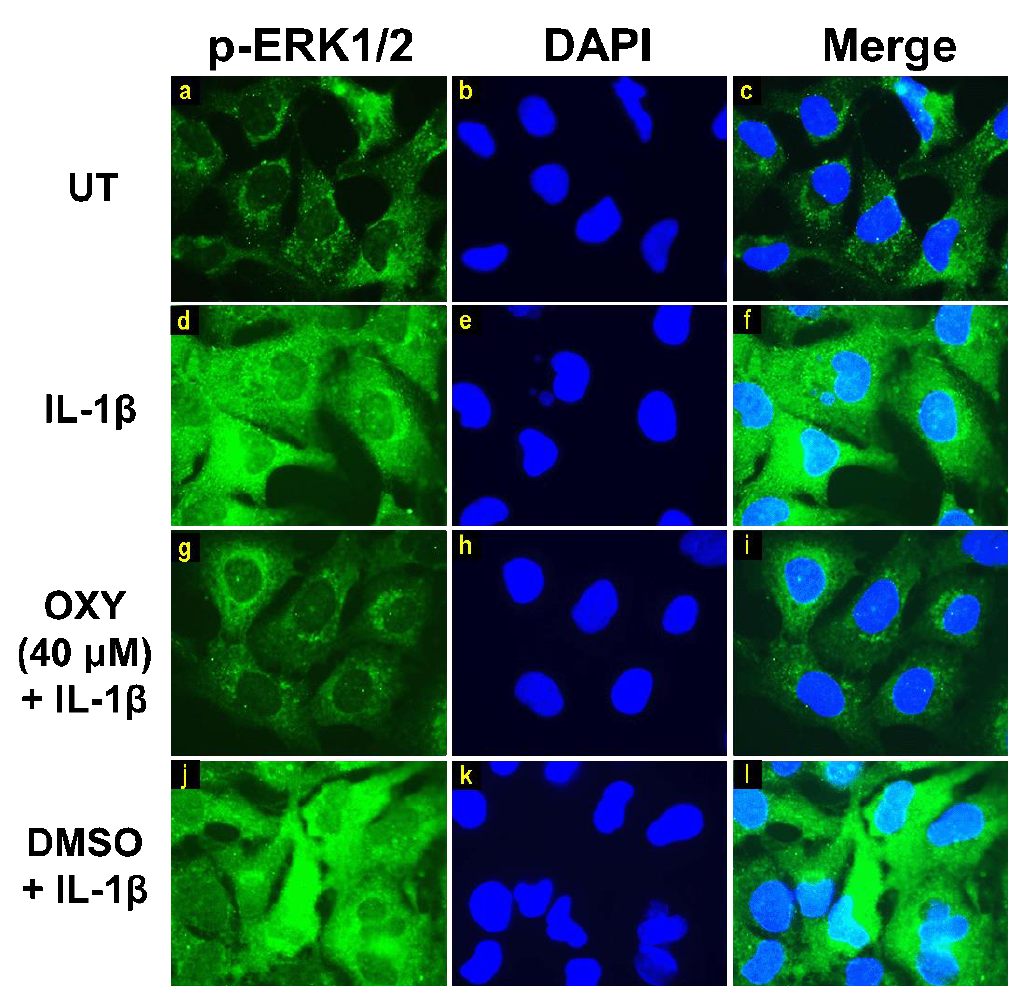
Figure 8. Immunofluorescence study for the effects of OXY on ERK1/2 phosphorylation in response to IL-1β activation in HMC3 cells. Representative images from immunofluorescence study showing ERK1/2 phosphorylation (green) of untreated cells ( a–c ), IL-1β-stimulated cells ( d–f ), IL-1β-stimulated cells with the presence of OXY at 40 μM ( g–i ), or DMSO ( j–l ). Nuclei (blue) were stained with DAPI. The micrographs were captured at 100× magnification, and data are representatives of three replicates.